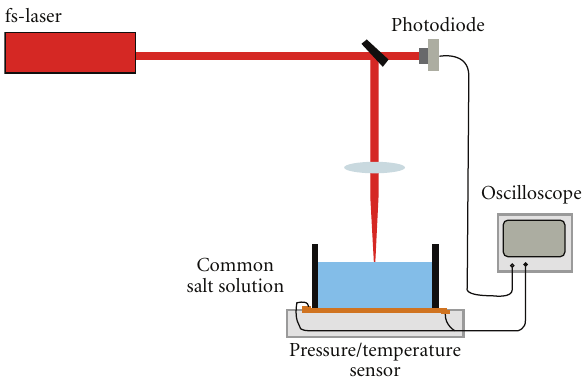
Figure 3: Temperature change in H 2 O with the Er:YAG laser